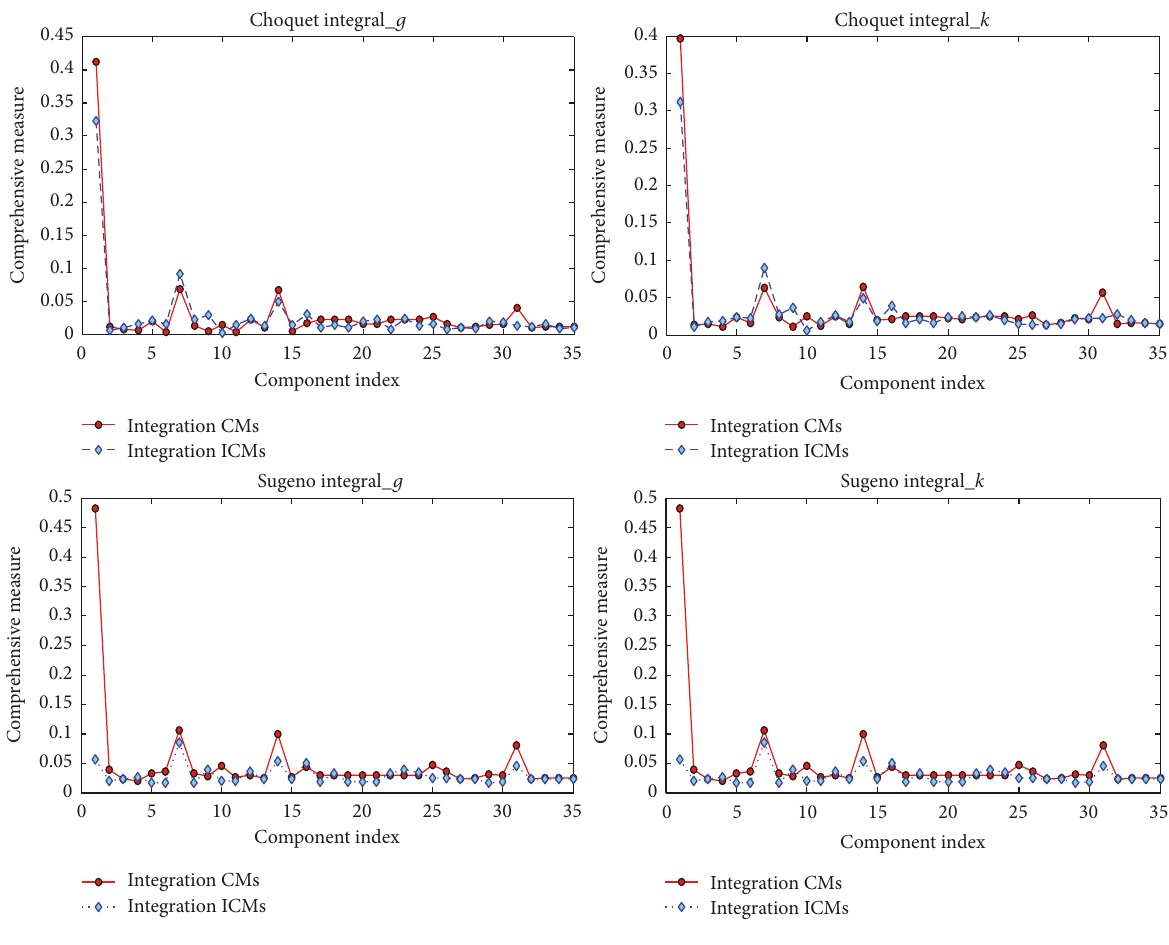
Figure 10: The results of integration CMs and